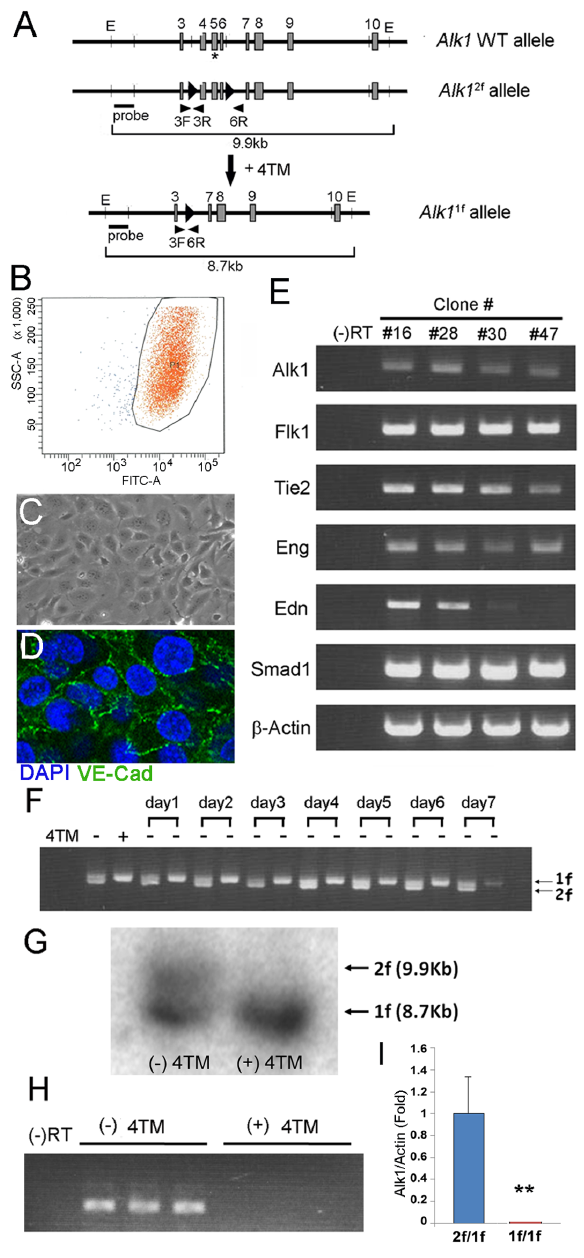
Figure 1. Establishment of R26 CreER/ + ; Alk1 2f/1f pulmonary en- dothelial cell line, and effective deletion of the Alk1 gene by 4TM treatment. A. Schematic diagram of the Alk1 wild-type, Alk1 2loxP (2f), and Alk1 1loxP (1f) alleles. Exons and loxP sequences are denoted by boxes and arrowheads, respectively. Locations of primer pairs detecting specific regions containing loxP sequences for the genomic PCR analysis and the probe recognizing the 5 9 region of the Alk1 gene which was used for the genomic Southern blot analysis are indicated. Note that exon 5 encodes the transmembrane domain (indicated by asterisk) of the Alk1 gene. B. After two rounds of FACS with DioAcLDL, about 98% of the sorted immortalized cells were positive for DioAcLDL. C and D. The sorted cells exhibited EC-characteristic polygonal shapes and cell-cell contact inhibition at confluency, and they expressed VE- Cadherin at their junctions. E. Expression of EC-specific marker genes including Flk1, Tie2, Eng, and Edn – along with Alk1 and Smad1– was examined by RT-PCR analysis on clonally expanded 2f/1f-pECs (from 5 cells per well). Amongst several isolated clones, clone # 28 showed the EC morphology and the high Alk1 and Edn expression levels and